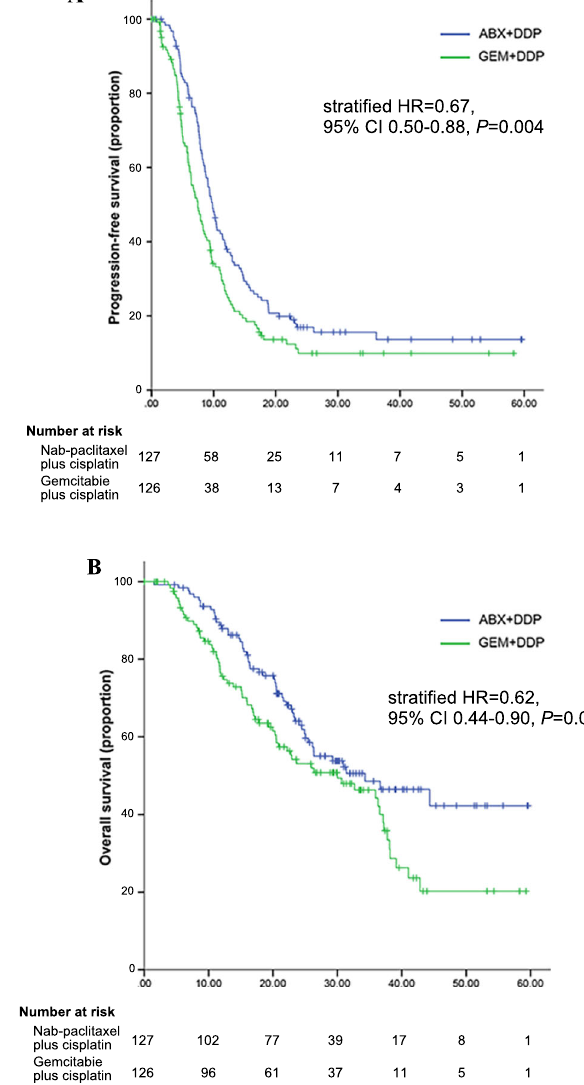
Fig. 2 Kaplan – Meier estimates of survival curves for AP and GP groups. Kaplan – Meier plot of PFS ( A ) and OS ( B ). Data for the ITT population. Treatment effects were compared using the log-rank test; HRs and corresponding 95% CIs were estimated using Cox-proportional-hazard regression model. P values are one-sided with no adjustment for multiplicity. HR = hazard